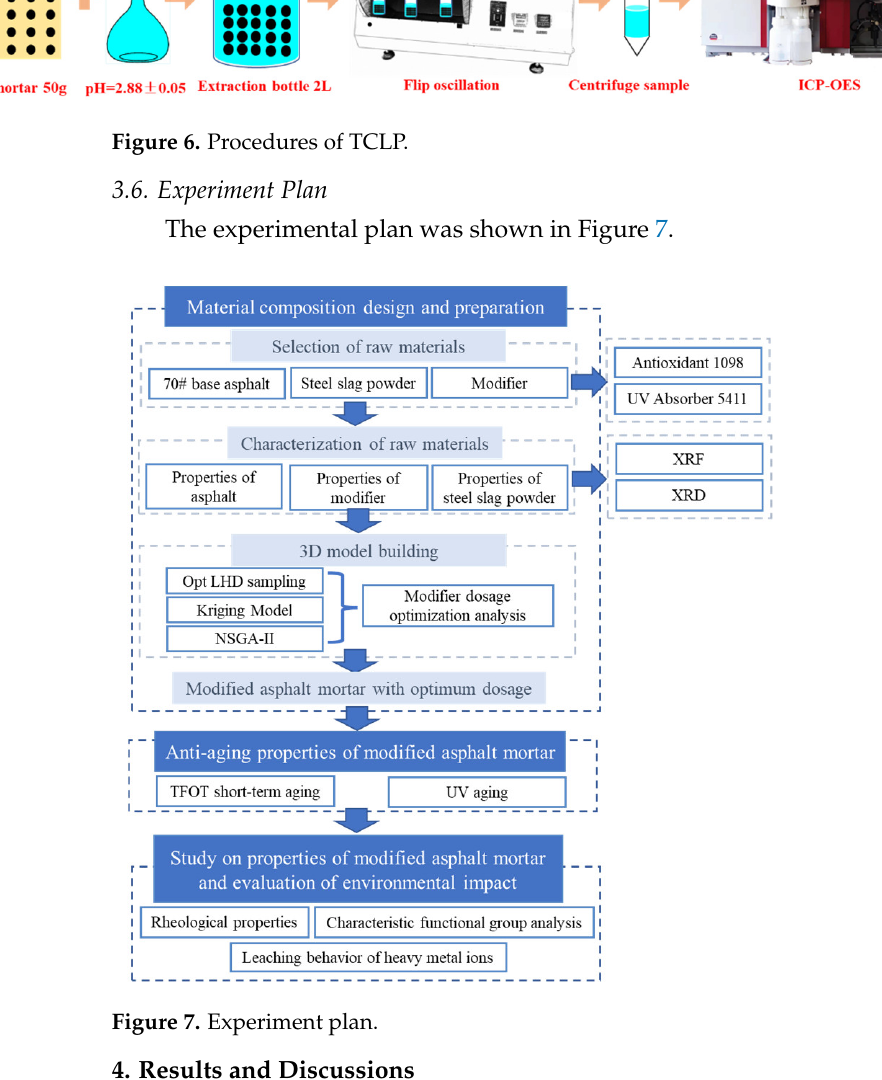
Figure 7. Experiment